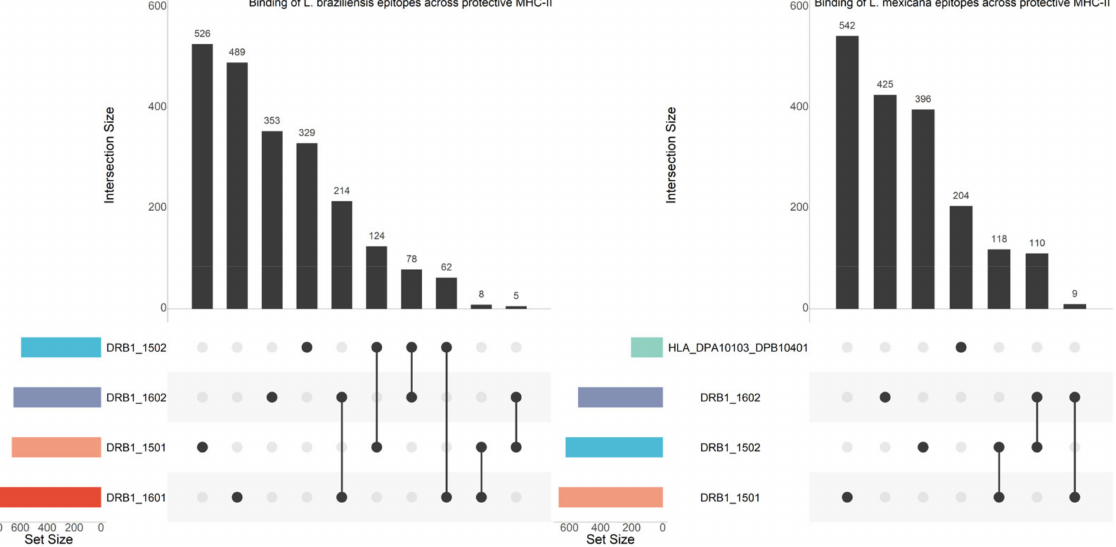
Figure 4. Upset Plots showing unique strong-binding epitopes of the CL-causing species ( L. braziliensis and L. mexicana ) that bind across the protection-associated alleles known for these species. The set size denotes the total number of strong-binding epitopes predicted for each species, while the intersection size denotes the number of strong-binding epitopes shared across the